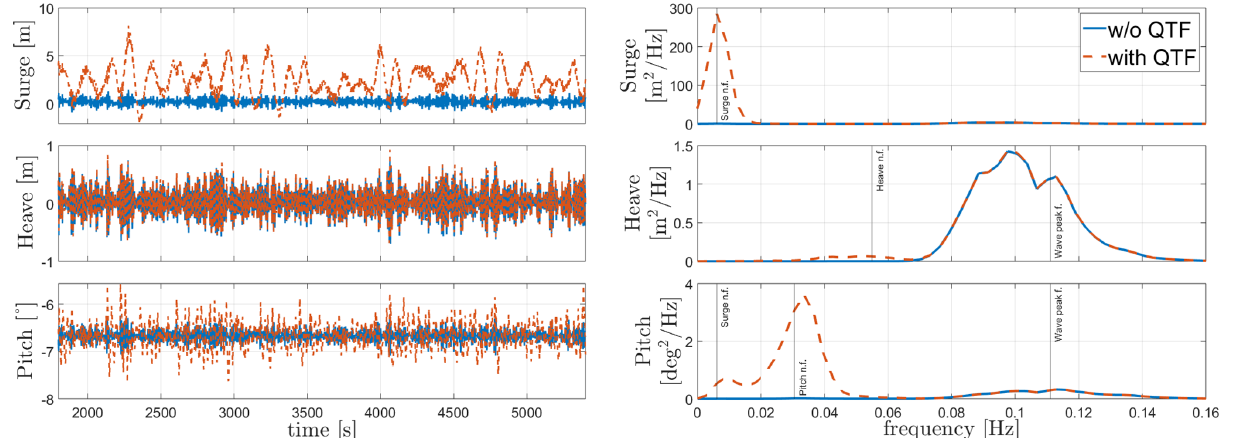
Figure 10. Activefloat response to irregular waves in the absence of wind ( T p = 9s ,H s = 5 . 11m).